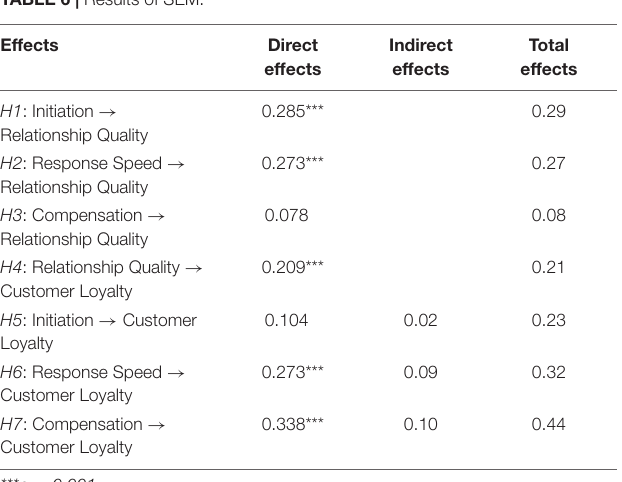
TABLE 6 | Results of